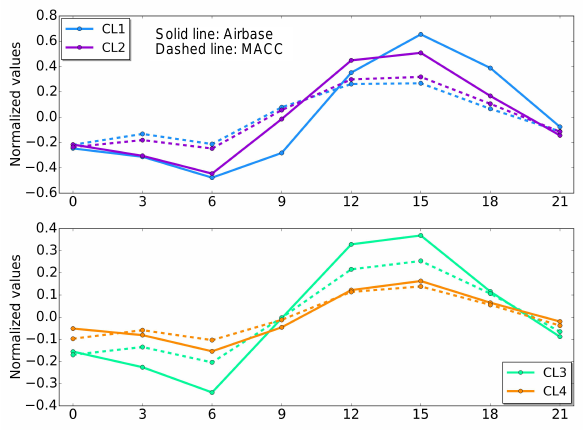
Figure 19. Diurnal cycles of cluster centroids; Airbase vs. MACC, second